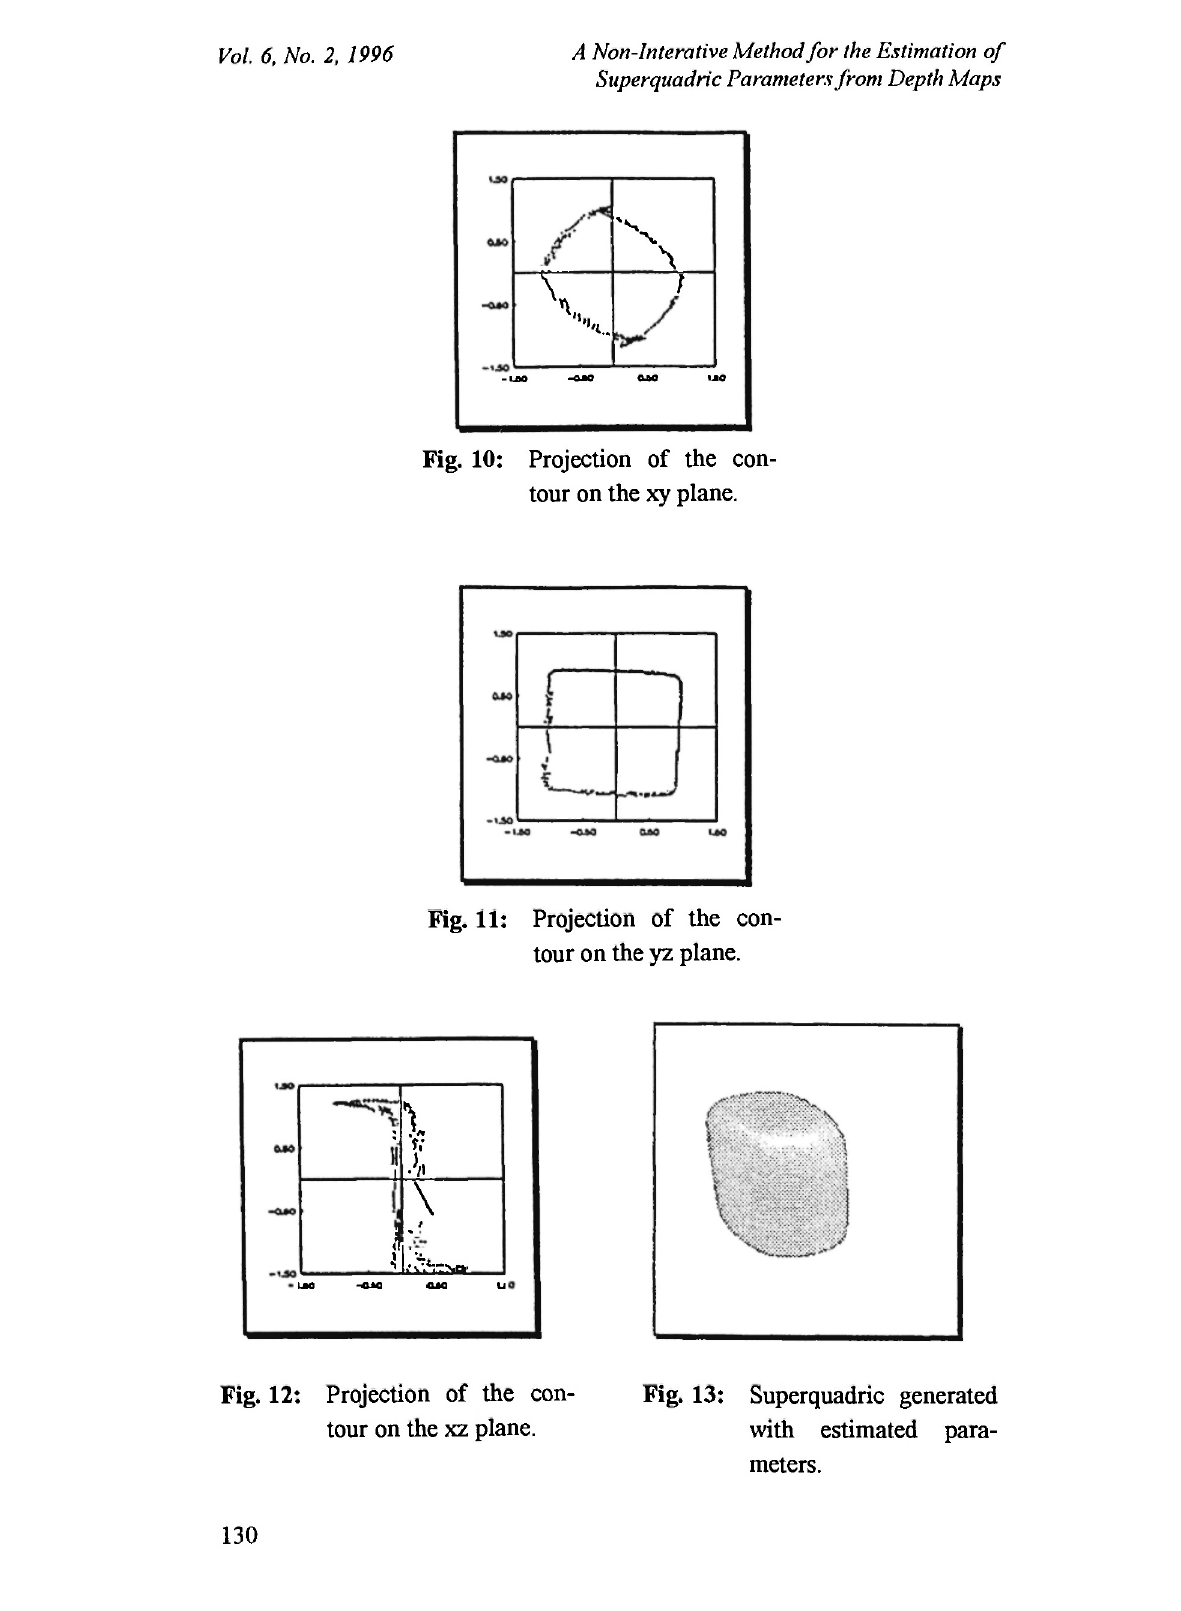
Fig. 12: Projection of the con- tour on the xz plane.